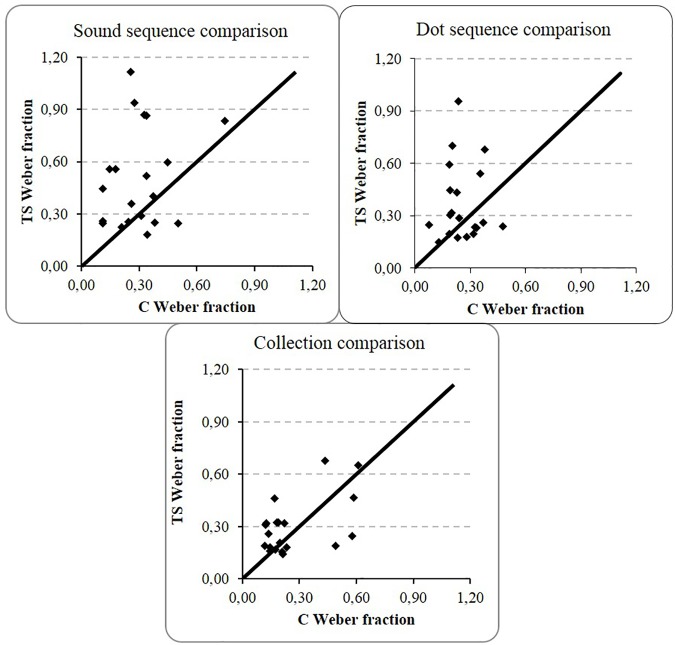
Association between Weber fractions within each Turner Syndrome (TS)—Control (C) pair for discrete magnitude comparison tasks.The central line represents the perfect match.